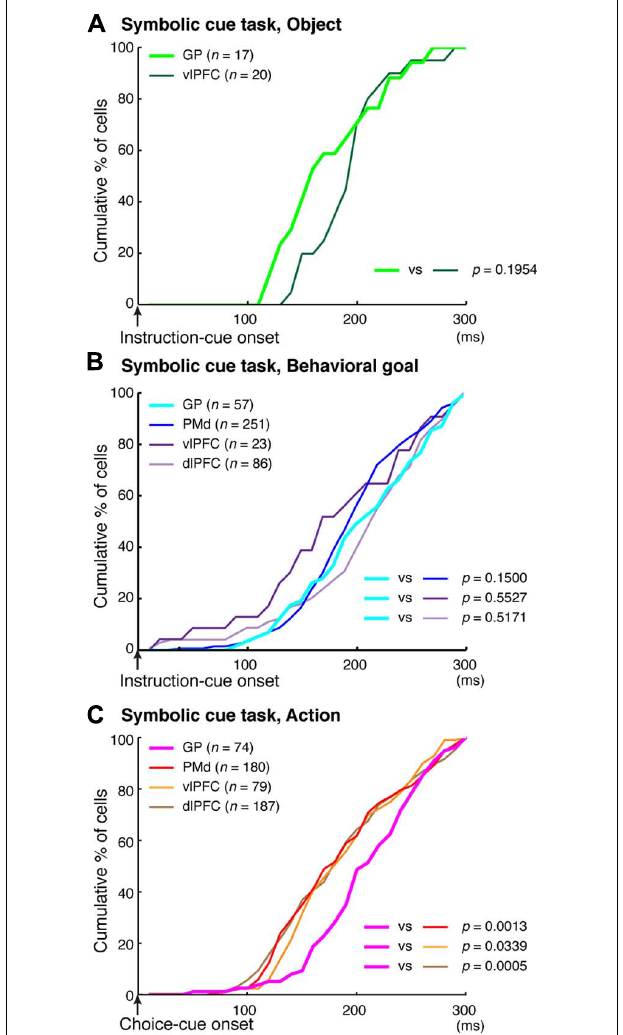
FIGURE 11 | Comparison of the development of selectivity for visual objects, behavioral goals, and actions. (A) Cumulative fractions of selectivity onset for visual objects in the GP (light green) and vlPFC (dark green) after instruction-cue onset in the symbolic cue task. (B) Cumulative fractions of selectivity onset for the behavioral goal in the GP (light blue), PMd (dark blue), vlPFC (dark purple), and dlPFC (light purple) after instruction-cue presentation in the symbolic cue task. (C) Cumulative fractions of the onset of action selectivity in the GP (pink), PMd (red), vlPFC (orange), and dlPFC (brown) after choice-cue onset in the symbolic cue task. (A–C) The p -values indicate the results of the statistical analysis (Kolmogorov–Smirnov test) between the GP and the other three areas (adapted from Arimura etal., 2013).